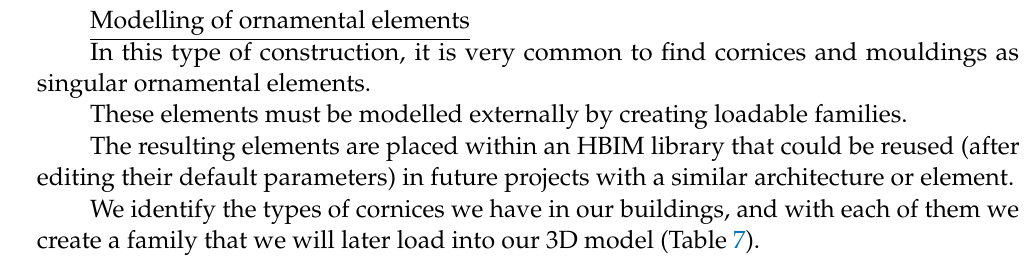
Figure 16. Screenshot of the modelled walls of the heritage buildings made with Revit software. Modelling of ornamental elements